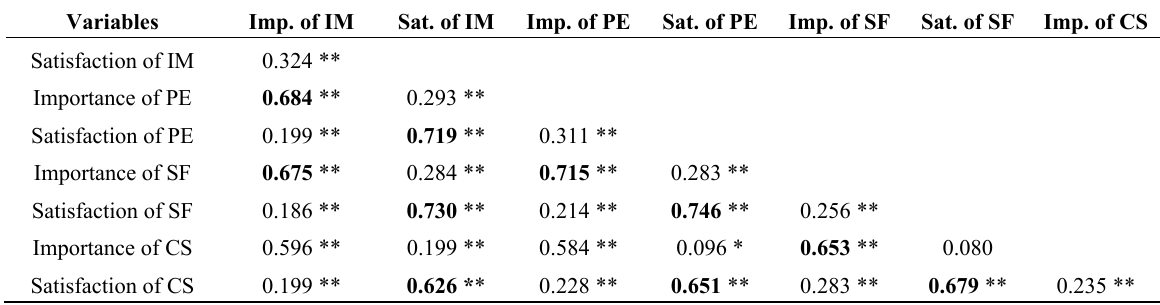
Table 2. The Pearson correlations between